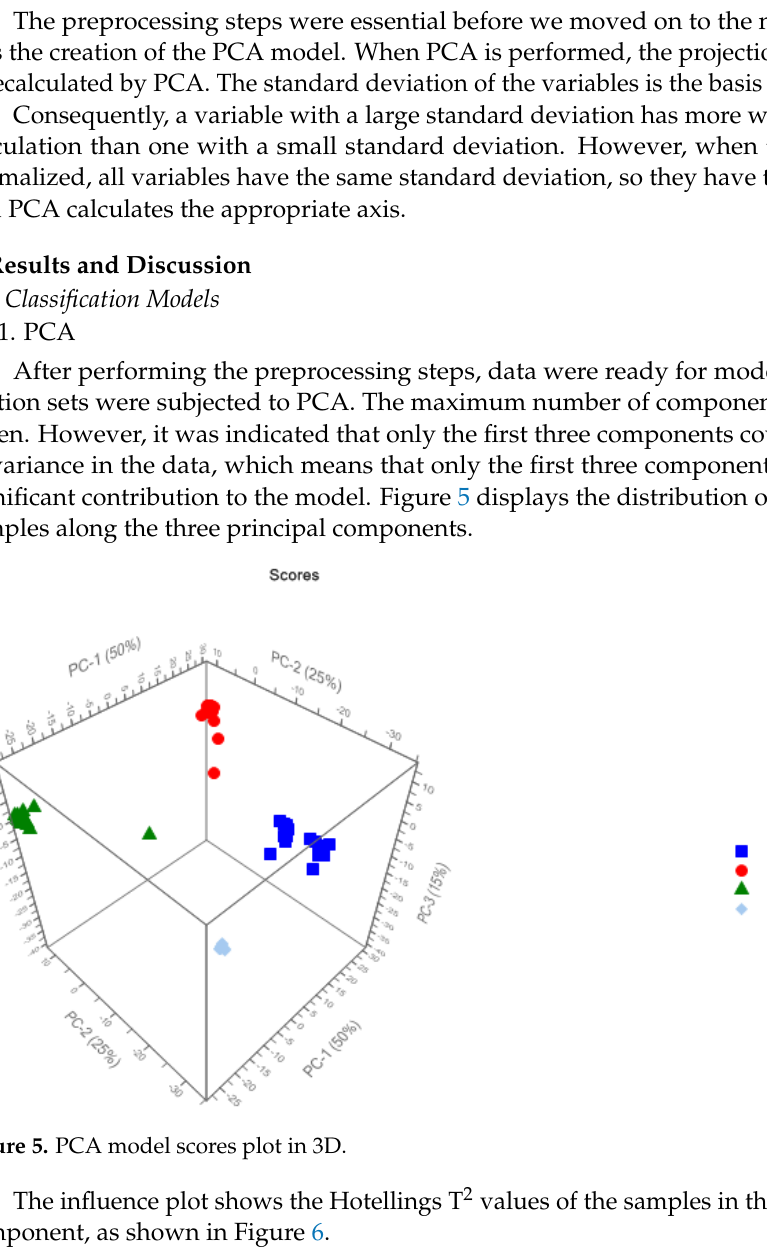
Figure 6. Influence